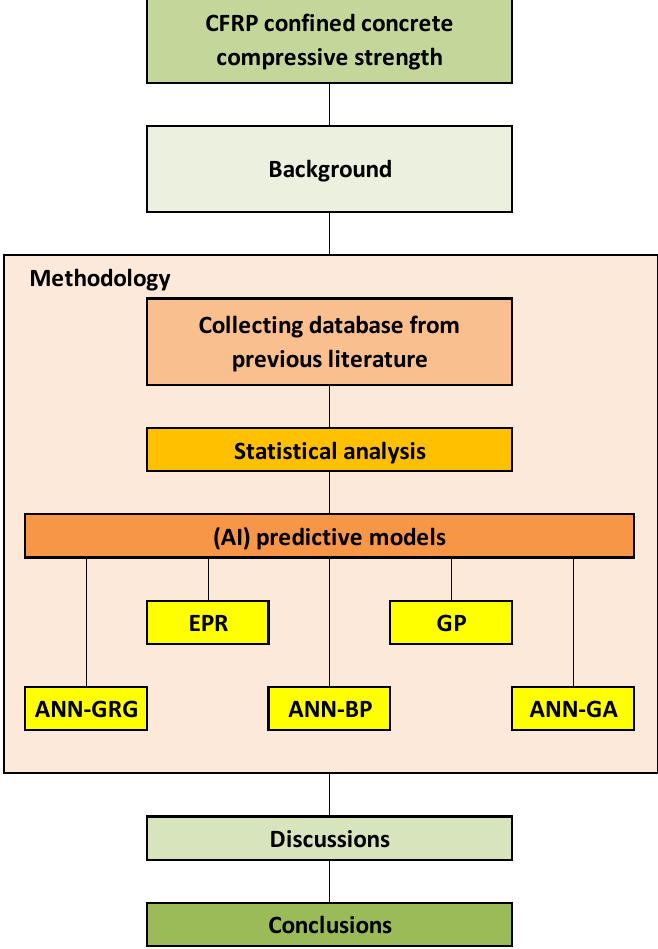
Figure 1. The formwork of the research .